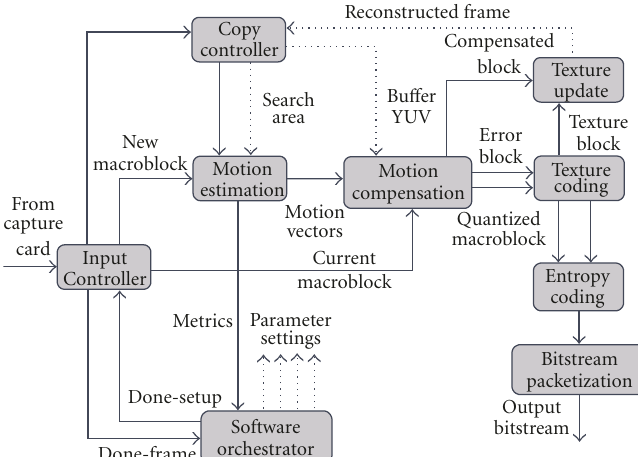
Figure 8: Task diagram for the par-hw and par-a configurations of the MPEG-4 simple profile encoder. Thin lines are scalar FIFOs, thick lines are block FIFOs, and dotted lines are shared variables. To avoid cluttering the diagram, parameter setting channels are shown only partially.